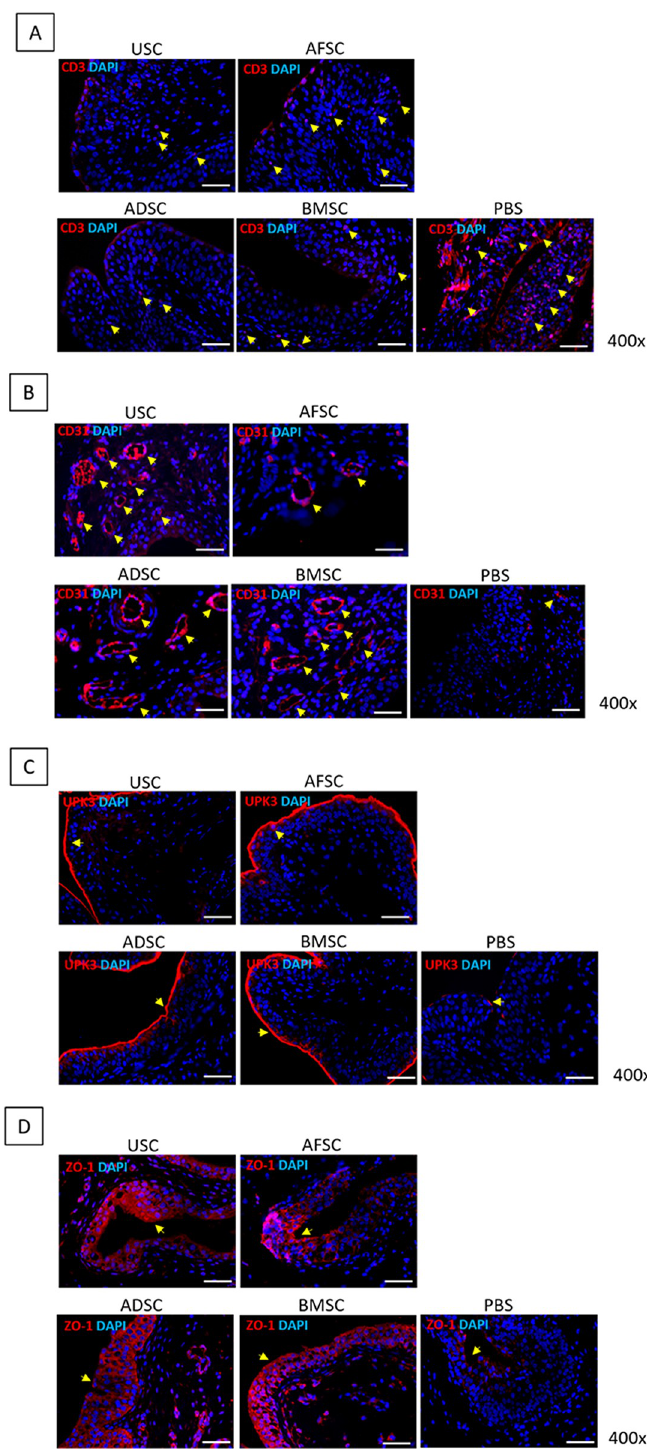
Fig 2. Gene expression results in USC-, AFSC-, ADSC-, BMSC- and PBS-injected groups. (A) CD3-positive T-cells were significantly reduced in SC-treated groups compared with PBS group. (B) CD31-positive cells were higher in USC- and BMSC-injected groups than in AFSC- and ADSC-injected groups. (C) UPK3-positive cell expression was similar among SC-treated groups. (D) ZO-1-positive cell expression was similar among SC-treated groups.